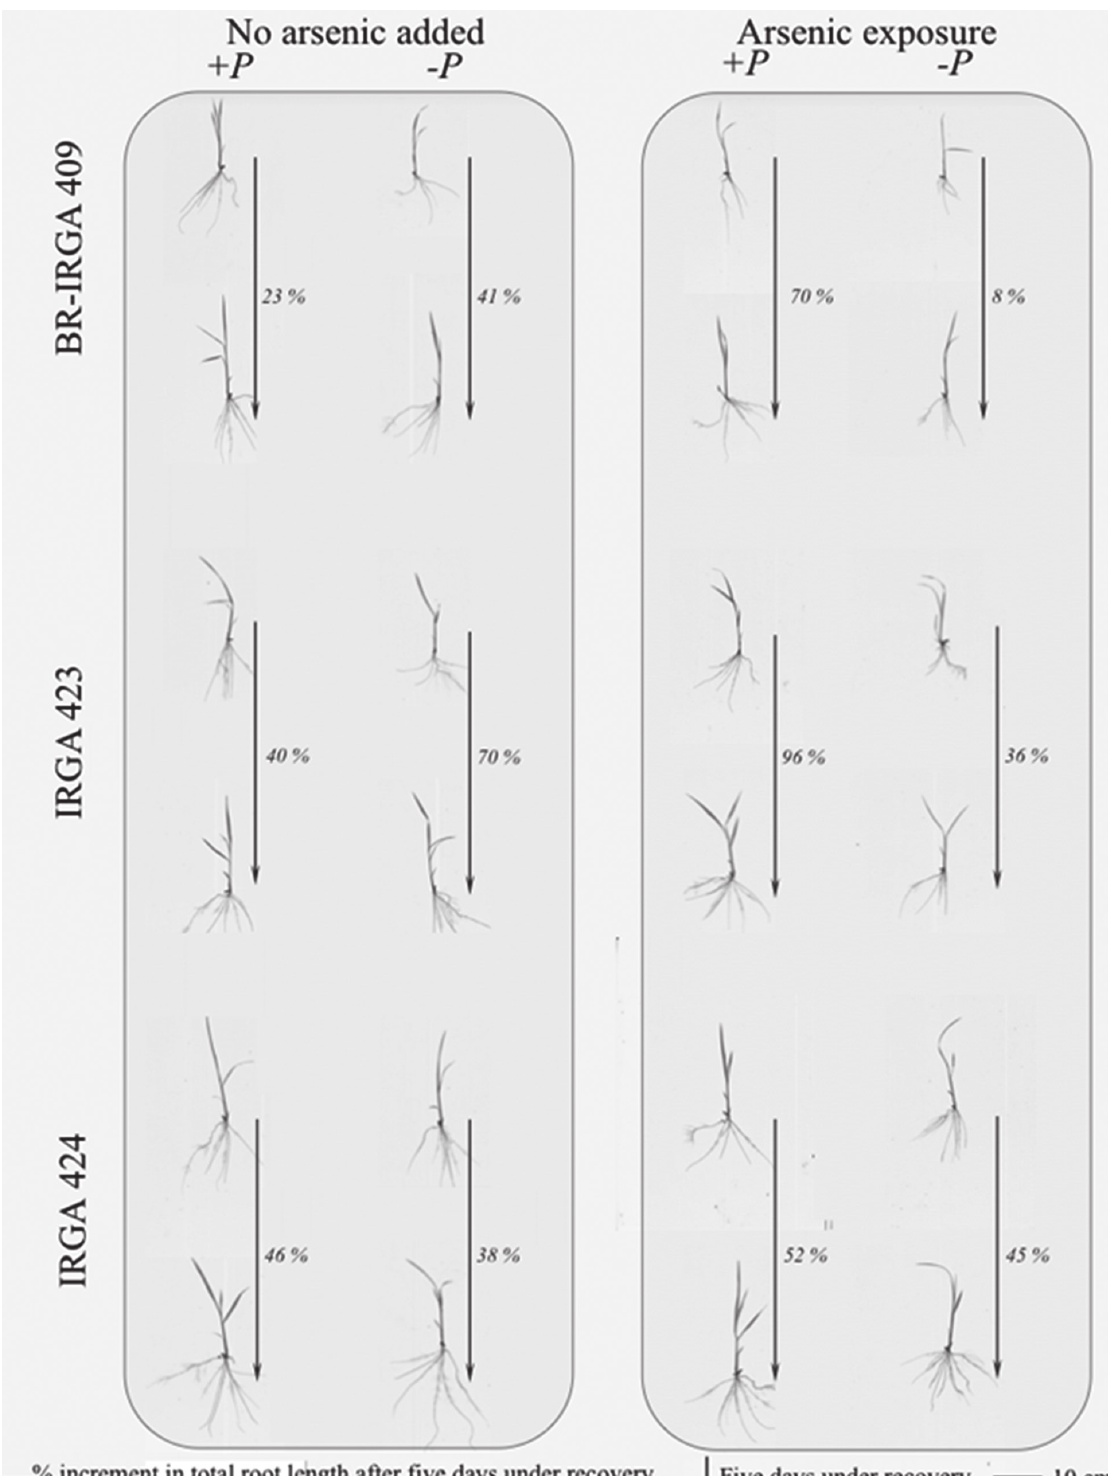
Figure 3 - Effect of phosphorus levels with or without arsenic exposure in rice plants on total root length increment (percentage inside the box) of plants after five days in control solution, recovery stage (see the colors in the online